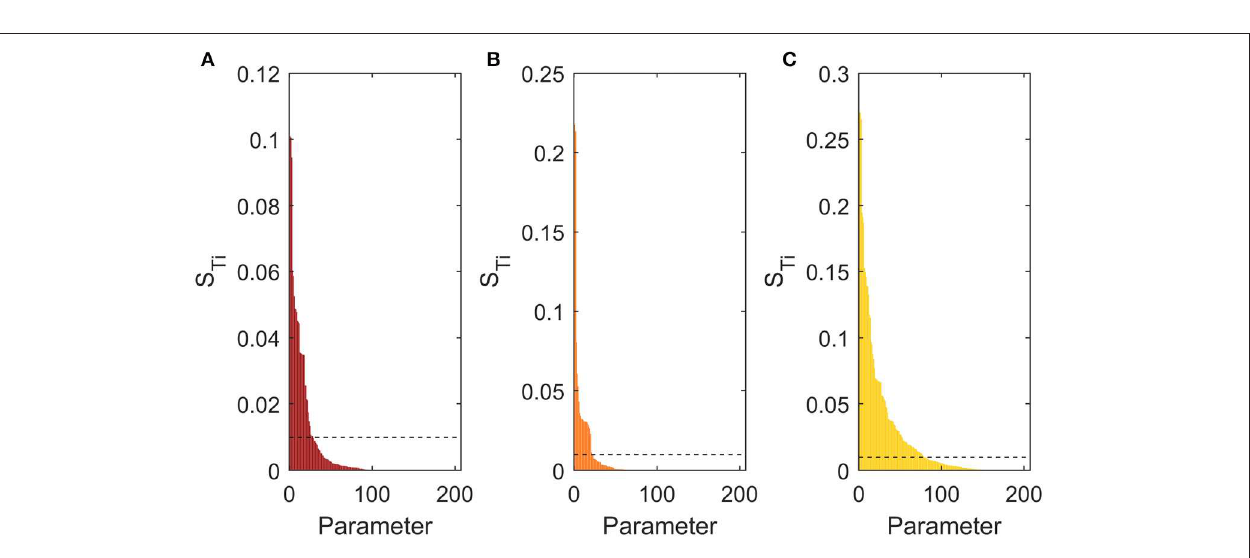
FIGURE 7 | Total sensitivity index of the k = 205 parameters on the outputs, sorted in descending order. (A) Sensitivity on HU min , (B) Sensitivity on CU min , (C) Sensitivity on T pp . Dotted lines indicate the proposed cut-off